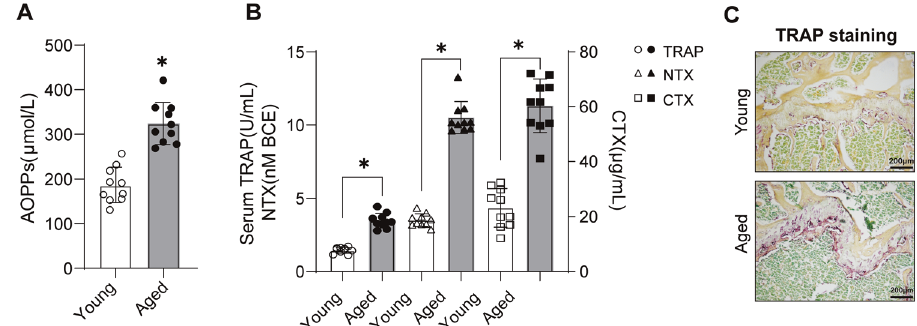
Fig. 1 AOPPs accumulation is associated with the enhanced osteoclastogenesis in aged mice. A Serum AOPPs level signi fi cantly increased in aged mice (18-month-old) compared with the young mice (3-month-old). B The serum bone resorption markers, such as TRAP (left Y axis), NTX (left Y axis) and CTX (right Y axis), were signi fi cantly increased in aged mice. C TRAP staining of tibia showed the increase of TRAP positive cells in aged mice. Data were presented as mean ± SD. * p < 0.05 versus the young